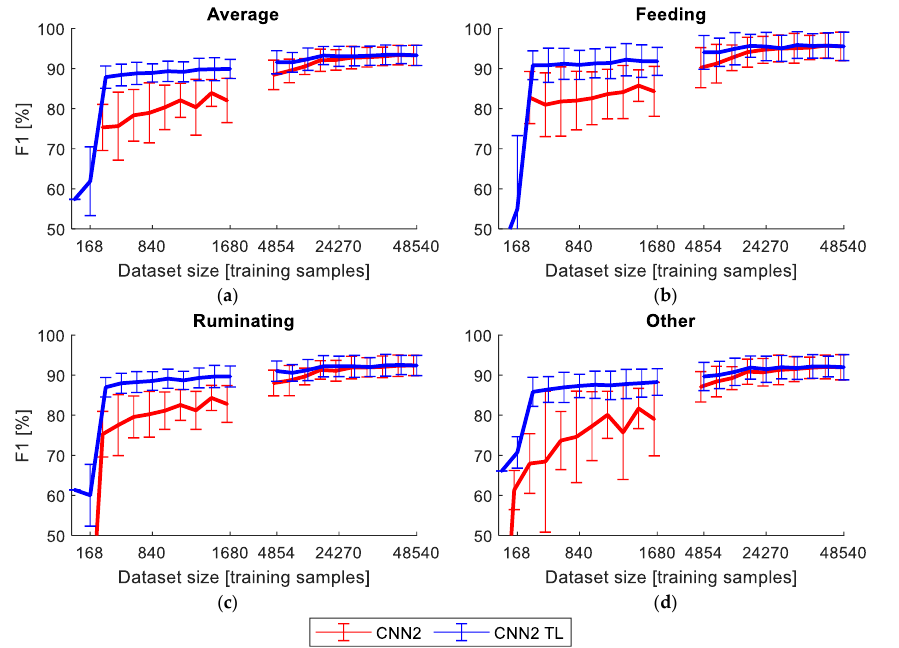
Figure 5. F1 score of the model CNN2 trained using randomly initialized model weights (CNN2) and by the transfer learning (CNN2 TL) for the window sizes of 60 s, depending on the training dataset size measured in training samples taken from the original dataset for the average F1 ( a ), feeding ( b ), rumination ( c ) and other behavior ( d ). The corresponding actual data after augmentation and balancing are: 336, . . . ;3192, 13,878, . . . ;132,762. The error bars represent the STD for 10-fold validation.